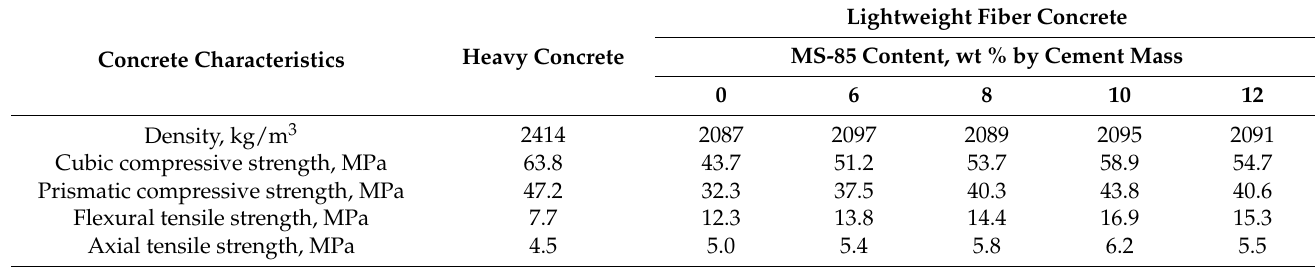
Table 12. Test results of prototypes of heavy concrete and lightweight fiber-reinforced concrete with different percentages of micro